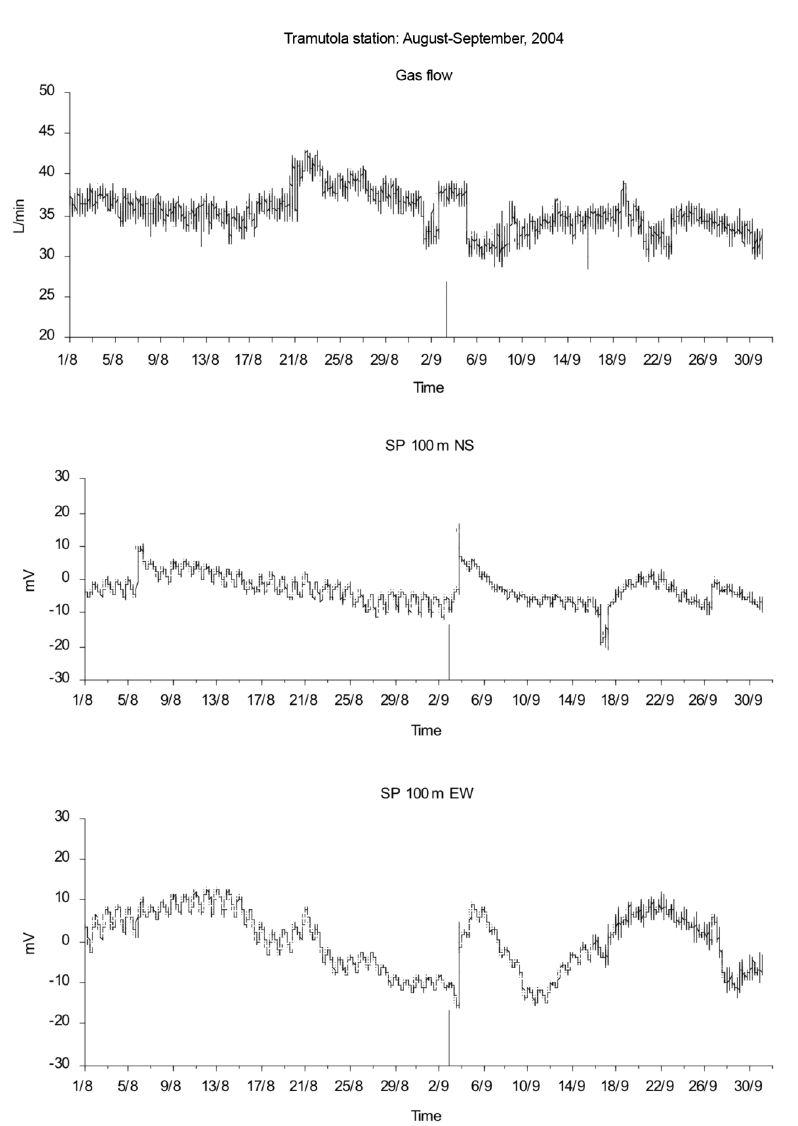
Fig. 6. Gas flow and self potential signals recorded at the Tramutola station between August-September 2004. A strong gas flow increasing was recorded before the seismic event on September 3 (grey bar), SP variations were post-seismic